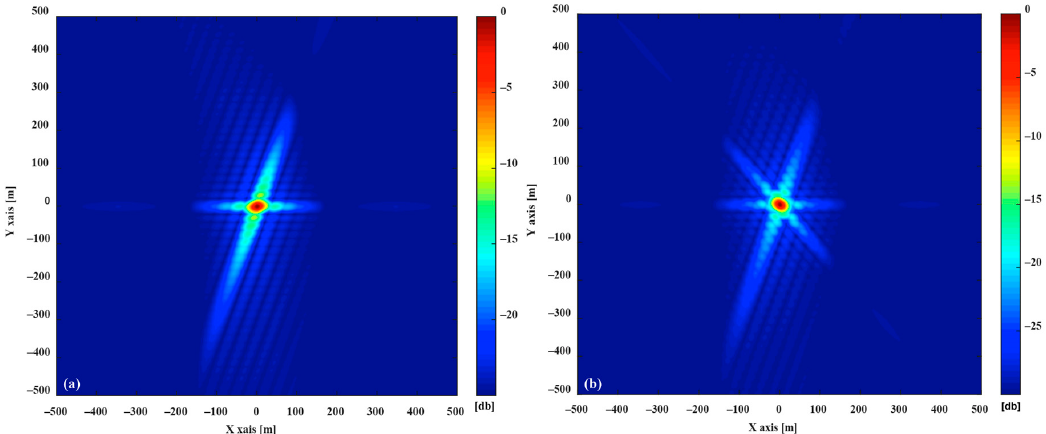
Figure 5. Simulated multi-satellite fusion MPSF: ( a )